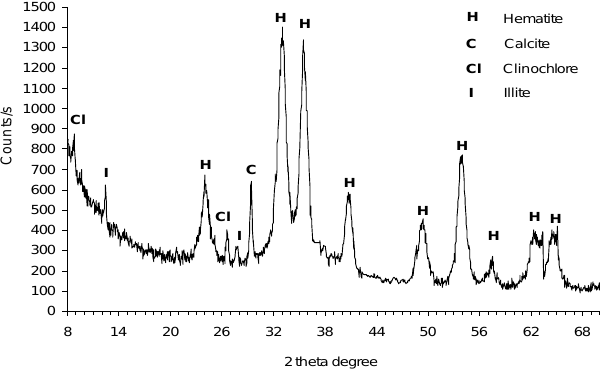
Fig. 8. XRD patterns of the > 2.5 µm particles retained in the head of the PM 2 . 5 inlet.